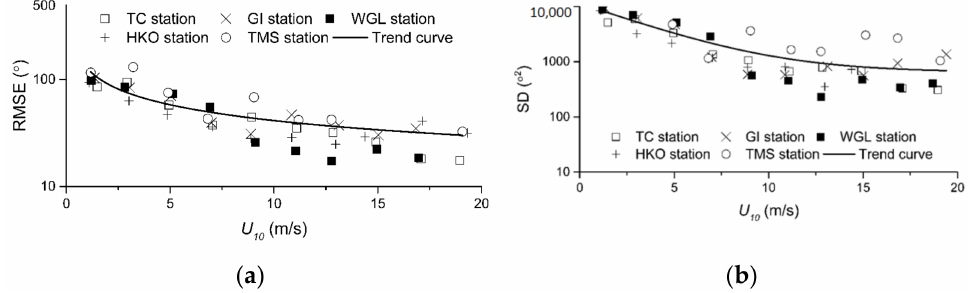
Figure 11. Wind direction error variation as a function of the U 10 ( a ) RMSE of wind direction; ( b ) SD of wind